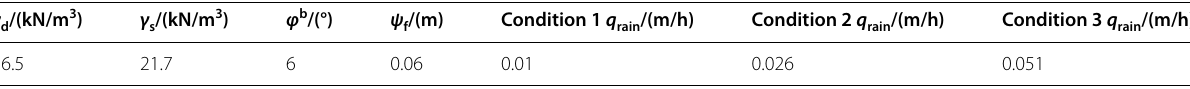
Table 3 Soil physical parameters and rainfall conditions